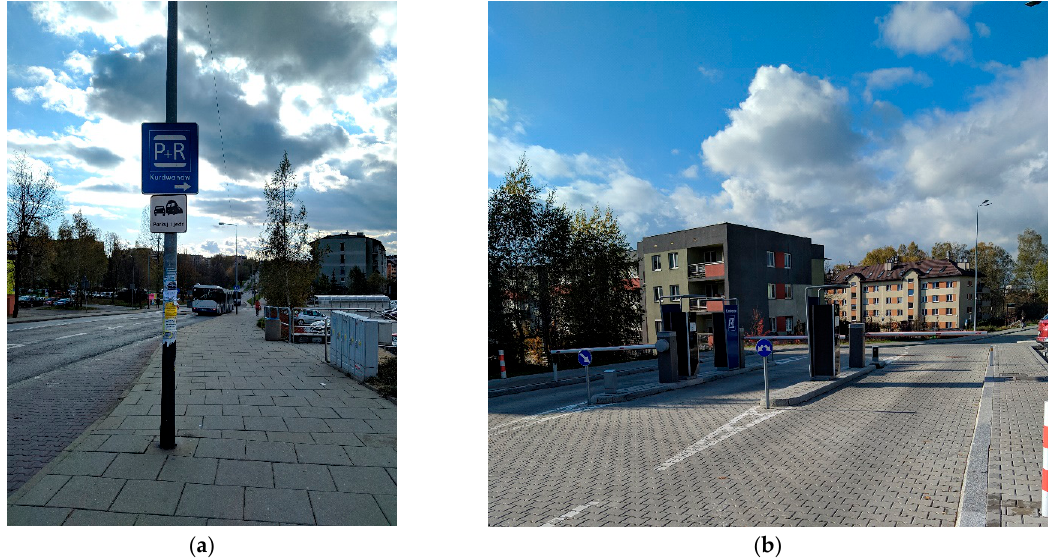
Figure 4. P&R parking in Cracow; (a) example of parking location marking: (b) devices of the Ticket Control System and the Toll Collection System. Energies 2020 , 13 , x FOR PEER REVIEW